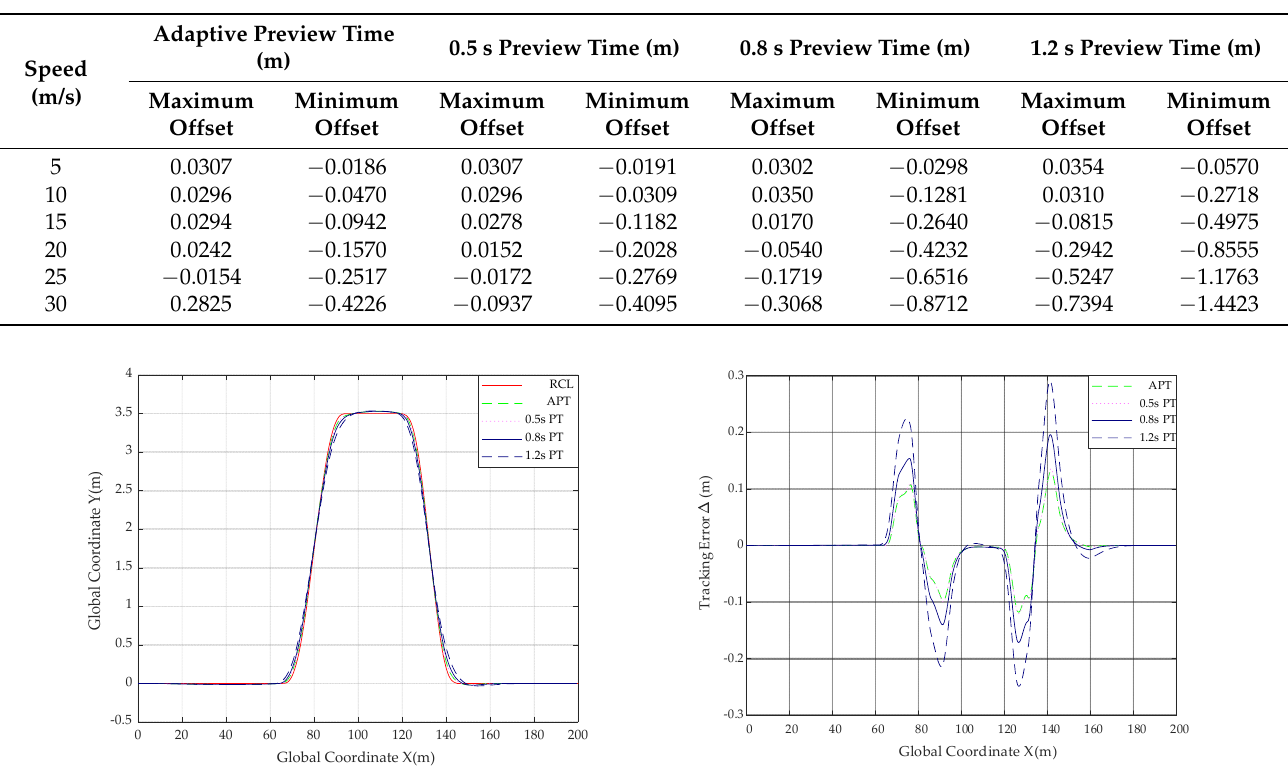
( b ) Comparison of tracking error at 5 m/s with dif ‐ Figure 12. Comparison of trajectories and tracking error with different preview times at 5 m/s.